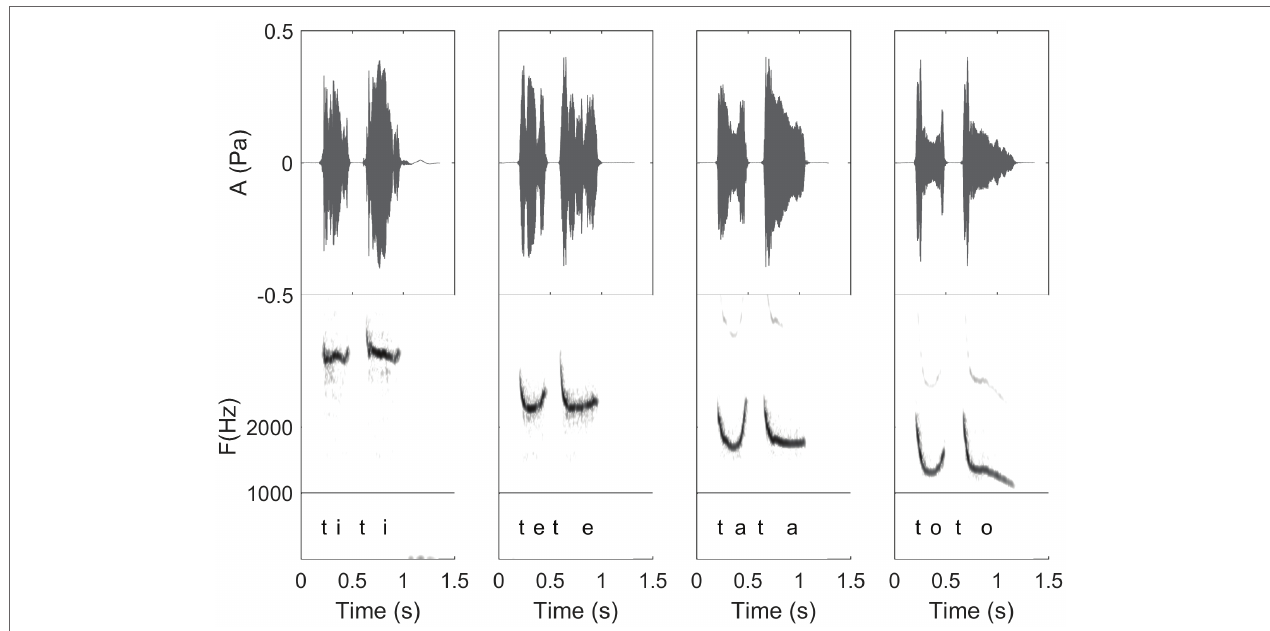
FIGURE 9 | Waveform and spectrogram of /titi/, /tete/, /tata/, and /toto/ as articulated by a Spanish whistler of the Canary Islands. These illustrate first the four different levels of vowels of a same whistler, but also the coarticulation with /t/ of these different frequency levels (see detailed explanation in “General description of dolphin and human whistled communication systems;” Recordings and edition by Julien Meyer, listen to sound extracts in Meyer and Diaz,